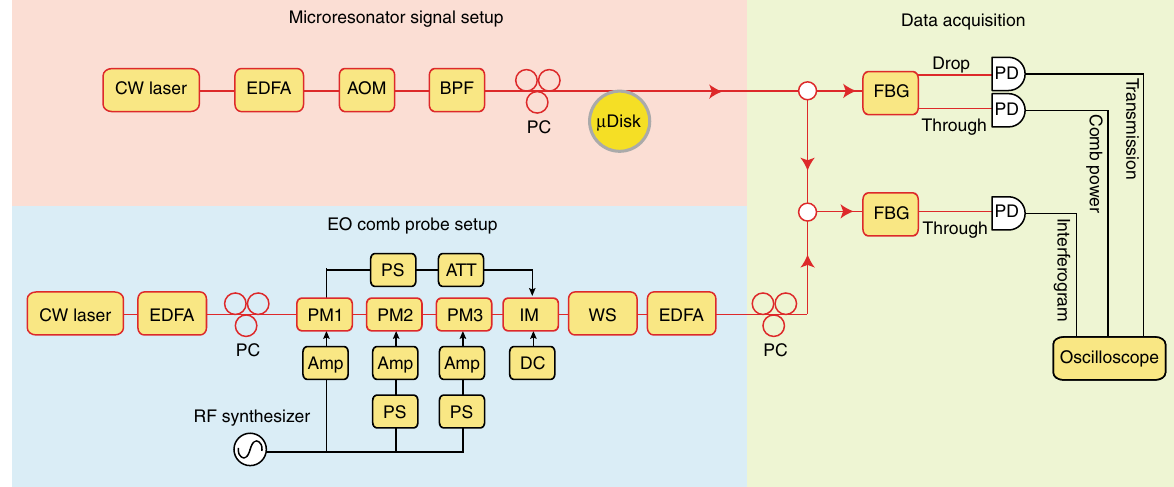
Fig. 6 Experimental setup. Schematic showing the three functional sections in the experiment. CW laser: continuous-wave laser; EDFA: erbium-doped- fi ber-ampli fi er; AOM: acousto-optic modulator; BPF: bandpass fi lter; PC: polarization controller; PM: phase modulator; IM: intensity modulator; PS: phase shifter; ATT: attenuator; Amp: RF ampli fi er; DC: voltage source; WS: optical waveshaper; FBG: fi ber-Bragg-gating; PD: